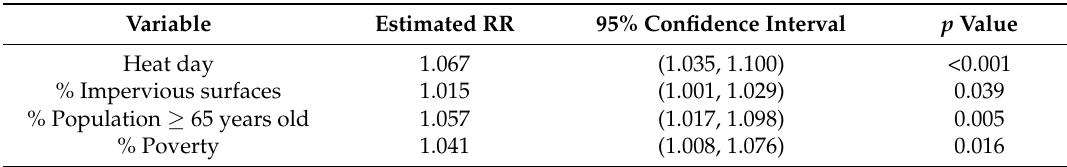
Table 3. Relative rate results: association between heat exposure (heat day versus non-heat day) and daily ALS call volume, adjusting for community-level factors 1 .